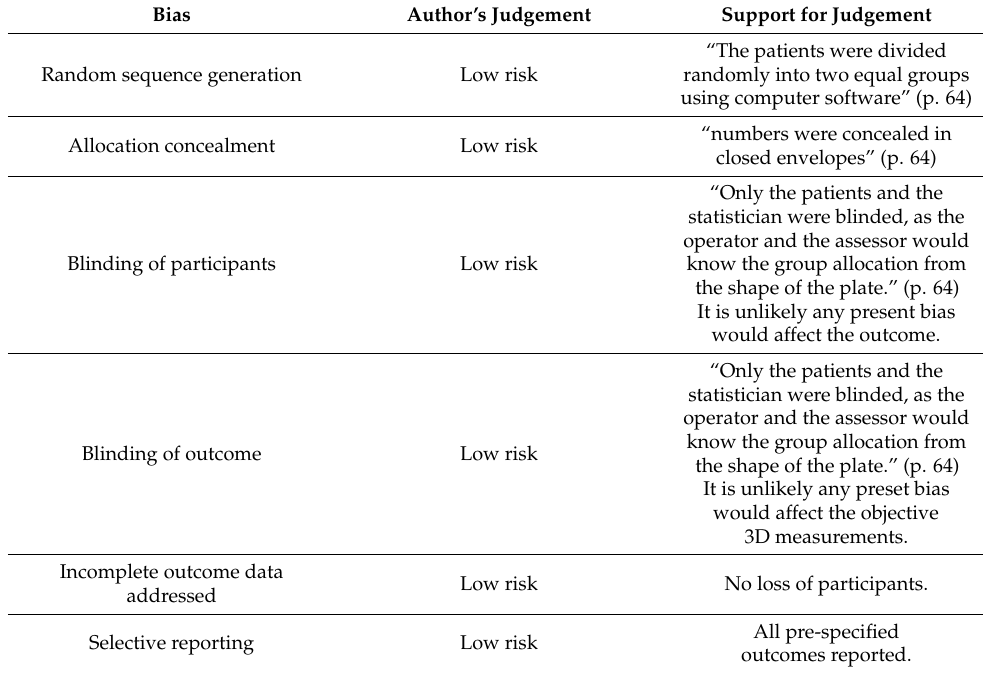
Table A2. Risk of bias analysis of Hanafy et al. (2020) using Cochrane Collaboration’s risk of bias tool.